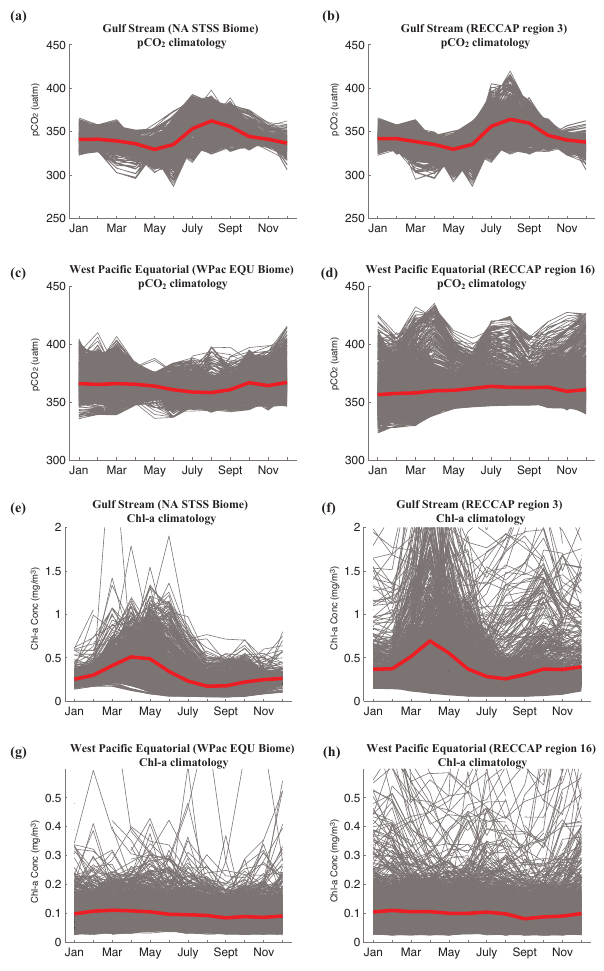
Figure 7. Comparison of biogeochemical variables in biomes vs. RECCAP regions 3 and 16. Seasonal p CO 2 climatology (a–d) and Chl a climatology (e–h) for two example regions: the North Atlantic Gulf Stream (a–b; e–f) and the west Pacific equatorial region (c–d; g–h)